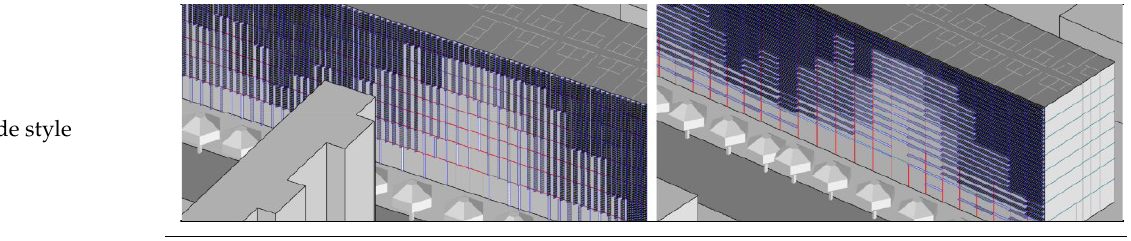
Table 3. The building facade shading form driven by building performance.